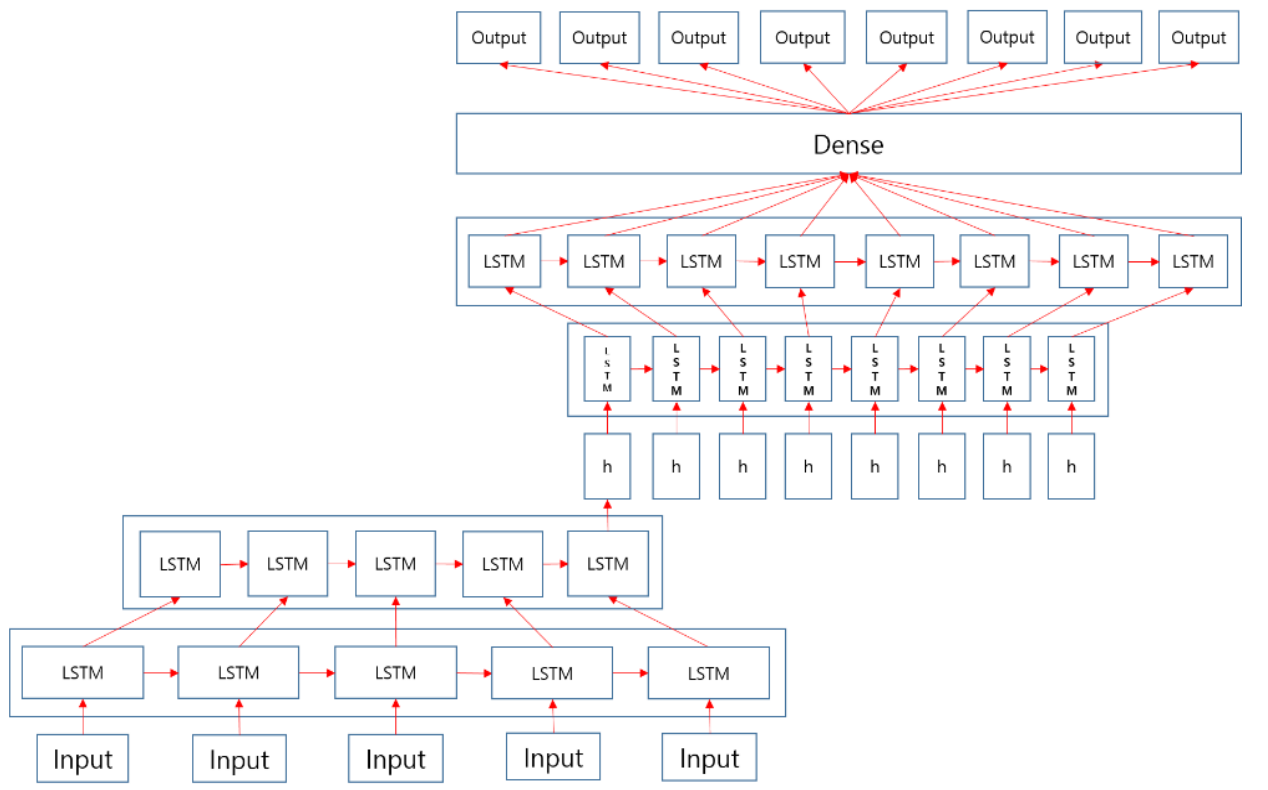
Figure 3. LSTM AutoEncoder model [2] with best performance when processing 5 h-old time series data entering as input, and estimated fine dust value after 1–8 h is output.